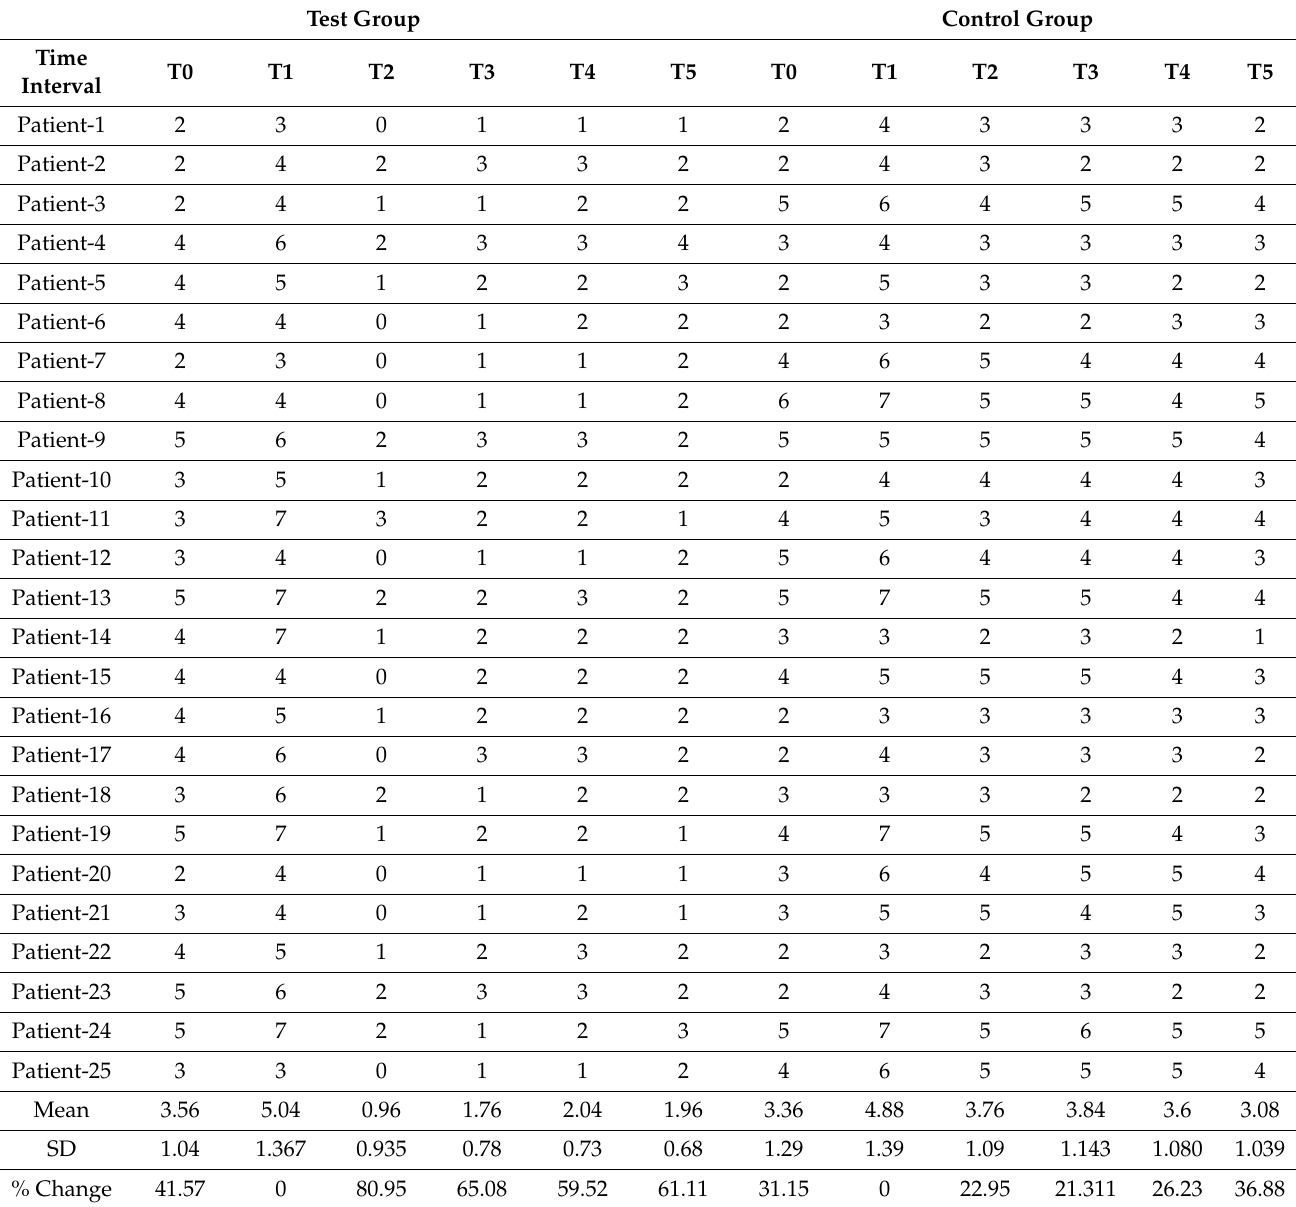
Table 1. VAS reading at different time intervals in two groups. (T0–Before Scaling; T1–After